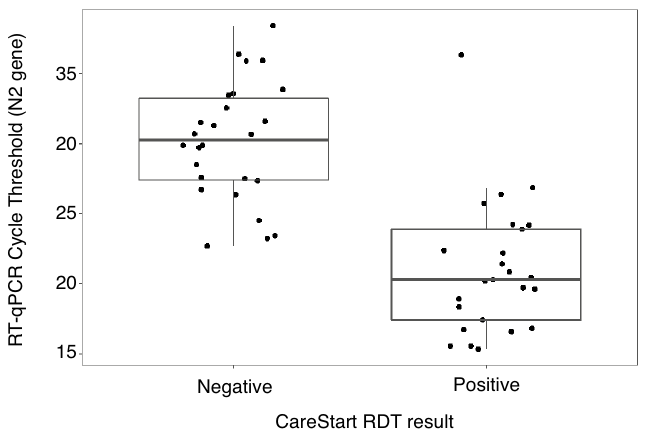
Figure 3. N2 gene RT-qPCR Cycle threshold (Ct) values corresponding to positive and negative CareStart rapid antigen test results for all RT-qPCR positive samples (n = 52).